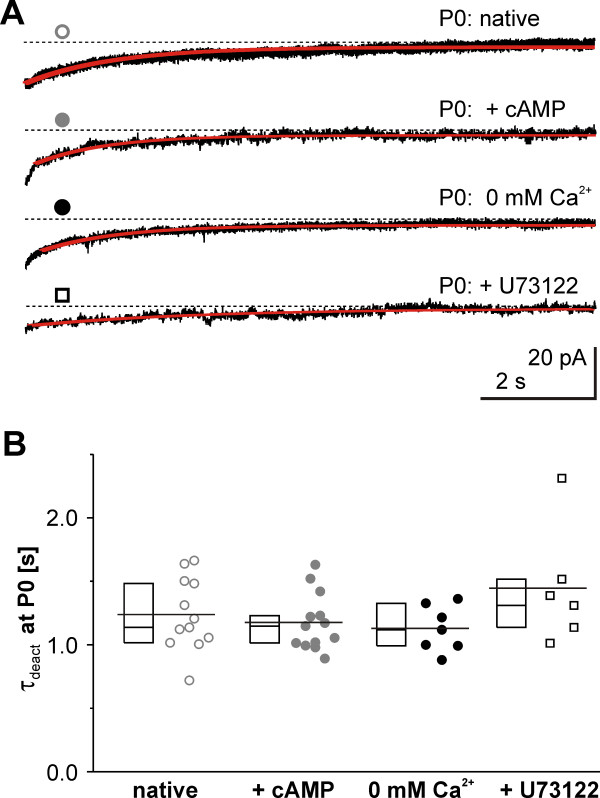
RobustIhdeactivation kinetics at P0. (A) Examples of Ih deactivations at −65 mV from a preceding activation step of −130 mV and corresponding single exponential fits at P0 under varying conditions. The course of Ih deactivation did not change when intracellular modulators (+cAMP or + U73122) were included or extracellular Ca2+ omitted (0 Ca2+). Symbols correspond to the coding in (B). (B) Deactivation time constants were not changed after experimental alterations of intracellular cAMP (100 μM, grey-filled circles), omitting extracellular Ca2+ (black-filled circles), or by adding the intracellular PLC blocker U73122 (open squares) compared to native P0 conditions (open grey circles). Data are presented with 25 to 75% box plots (left of respective data). The mean for each condition is indicated by a line comprising the box and individual data points.